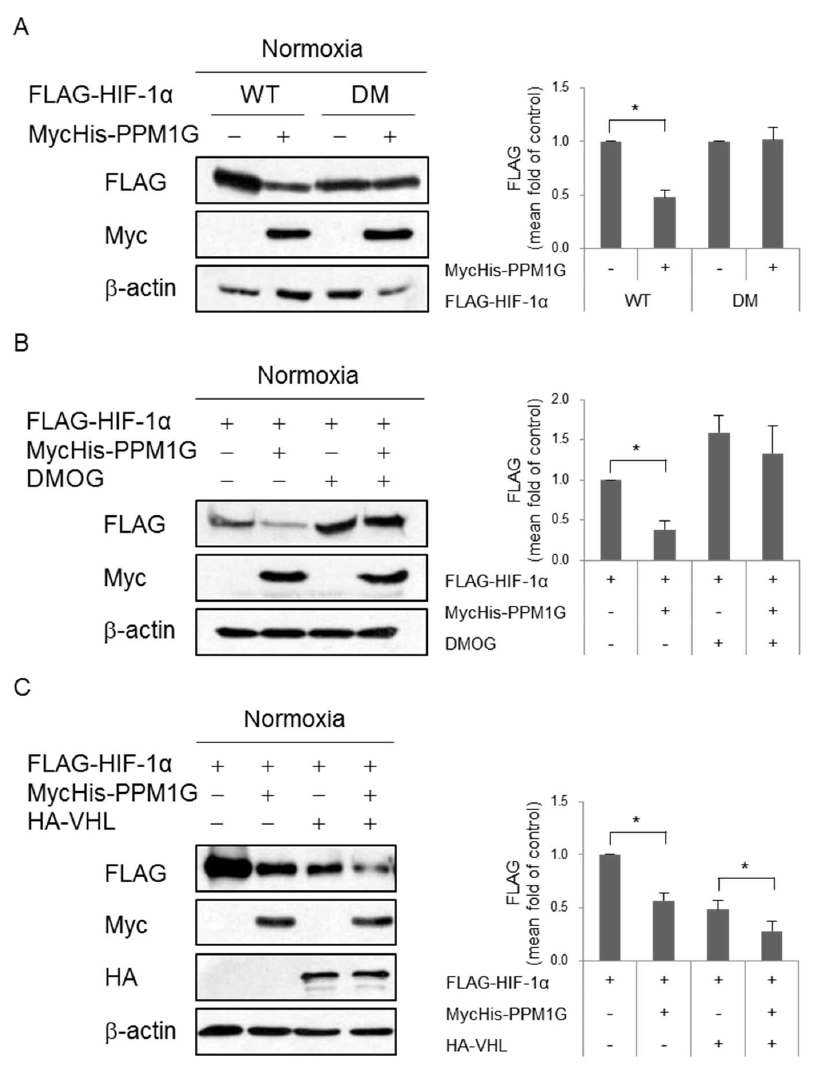
Figure 4. PPM1G reduces HIF-1α expression in a PHD-dependent, but VHL-independent, manner. Cells were transfected with the indicated vectors. Expression of each protein was determined by Western blotting. ( A ) HEK293T cells were co-transfected with MycHis-empty (−) or MycHis-PPM1G (+) and FLAG-HIF-1α-wild type (WT) or -P402A/P564A double mutant (DM); ( B ) PHD activity was blocked by treating the transfected HEK293T cells with 1 mM dimethyloxaloylglycine (DMOG) for 12 h prior to lysis; ( C ) 786-O cells, which do not express VHL and HIF-1α, were co-transfected with FLAG-HIF-1α, MycHis-PPM1G, and HA-VHL, and then exposed to normoxia. * p < 0.05; significantly different from the matched control group.